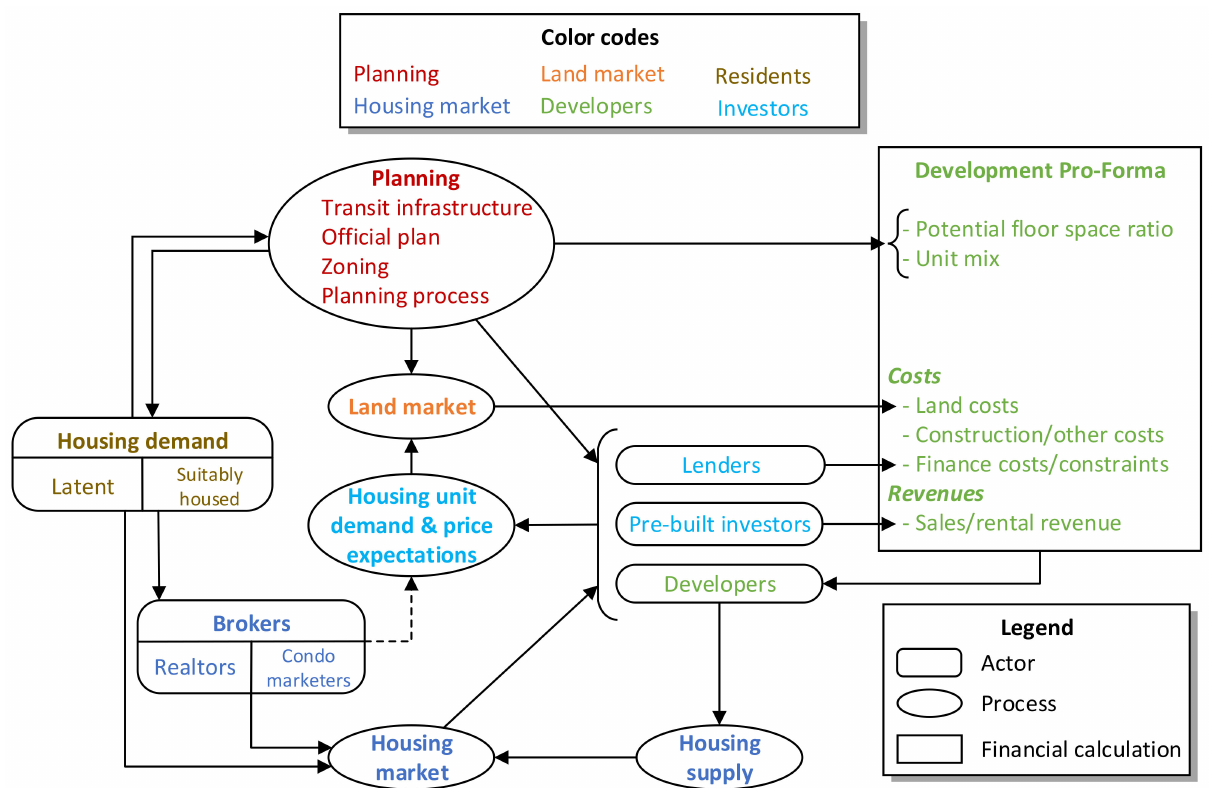
Figure 2. Qualitative systems map representing developers’ decision-making context: actors, pro- cesses, and calculations by shape, and actor realm by color; dashed line represents incomplete information flow. (Supplementary Materials Video